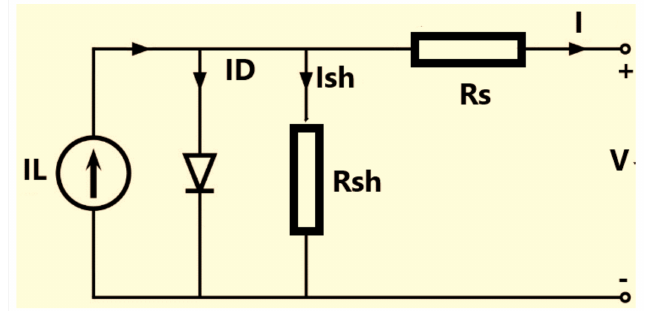
Figure 6. The practical equivalent circuit of a solar cell.